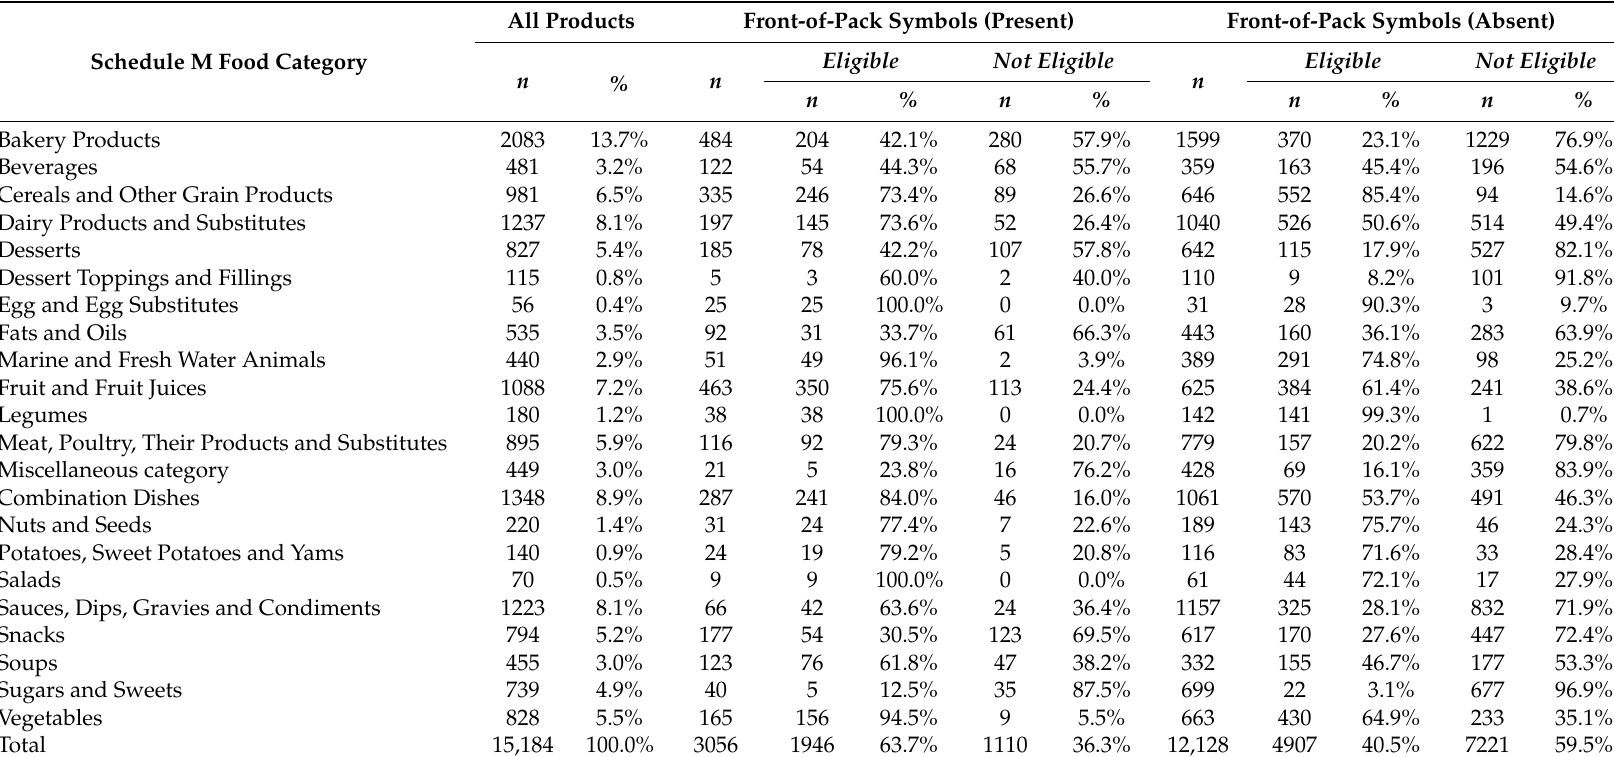
Table 4. Proportion of foods and beverages carrying unregulated front-of-pack (FOP) symbols that would or would not be eligible to carry such claims according to the FSANZ-NPSC, by Schedule M food category ( n =